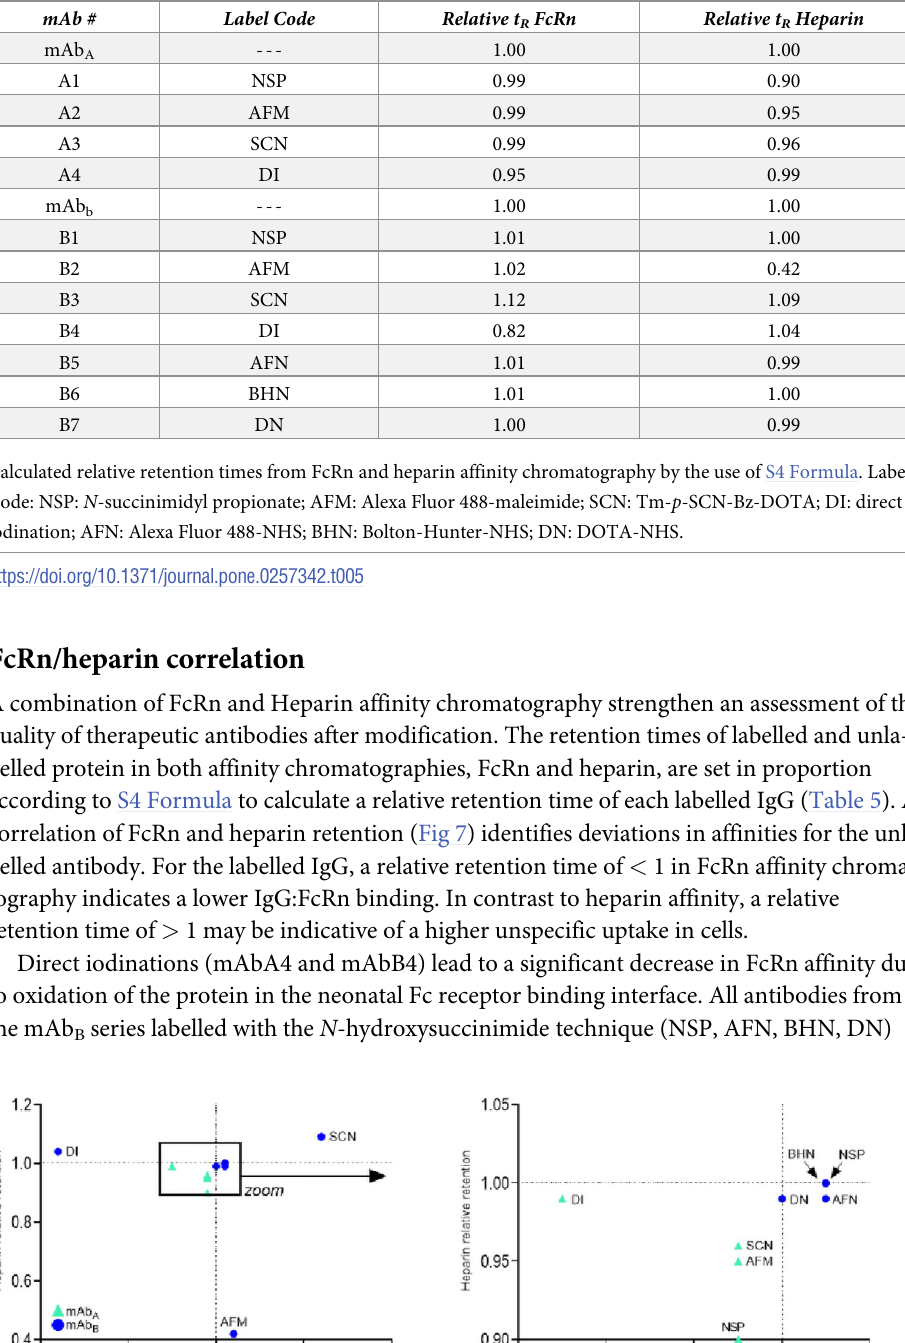
Table 5. Calculated relative retention times.